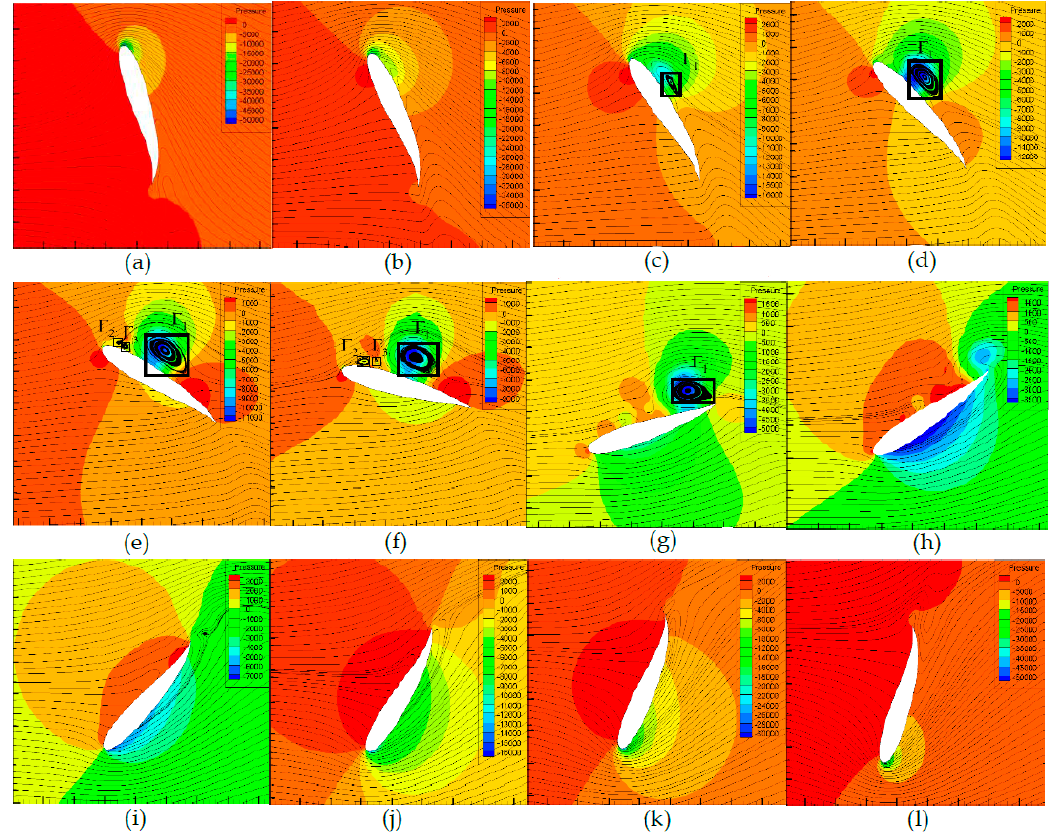
Figure 7. Contours of vortices with streamlines and pressure of flexible hydrofoil ( n = 5, δ c = 0.1 c , f * = 0.13) in the half-cycle. ( a ) θ = − 72 ° , ( b ) θ = − 65 ° , ( c ) θ = − 56 ° , ( d ) θ = − 45 ° , ( e ) θ = − 31 ° , ( f ) θ = − 16 ° , ( g ) θ = 16 ° , ( h ) θ = 31 ° , ( i ) θ = 45 ° , ( j ) θ = 56 ° , ( k ) θ = 65 ° , ( l ) θ = 72 ° .